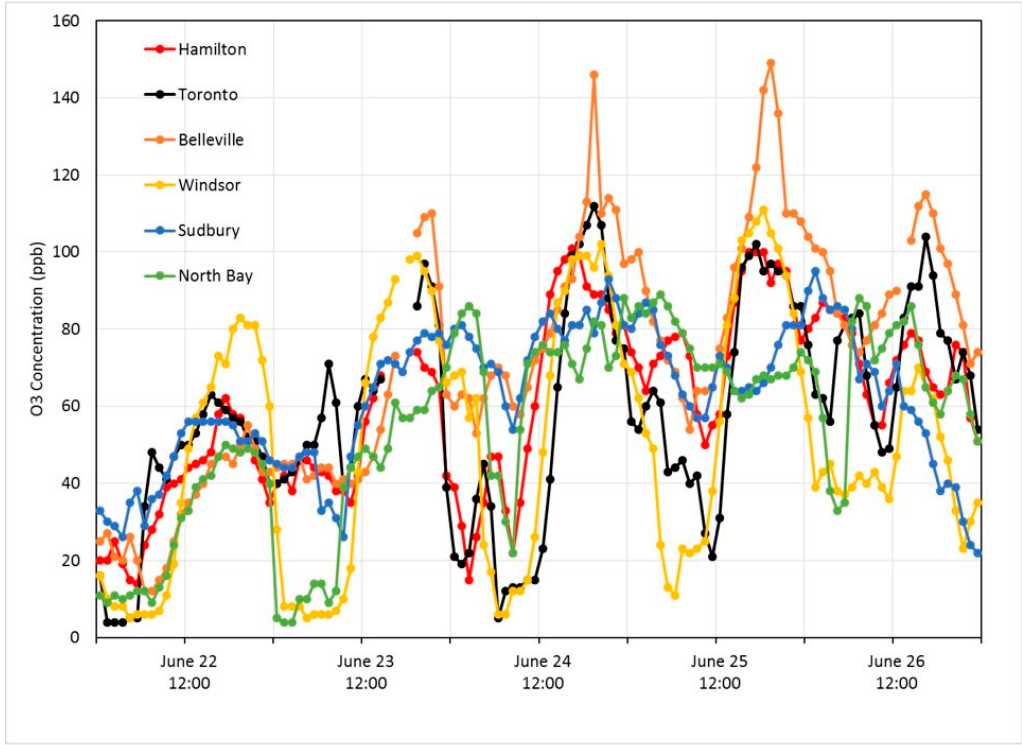
Figure 3. O 3 hourly concentrations, 22–26 June 2003. Dates are shown at EDT (local time) 12:00.